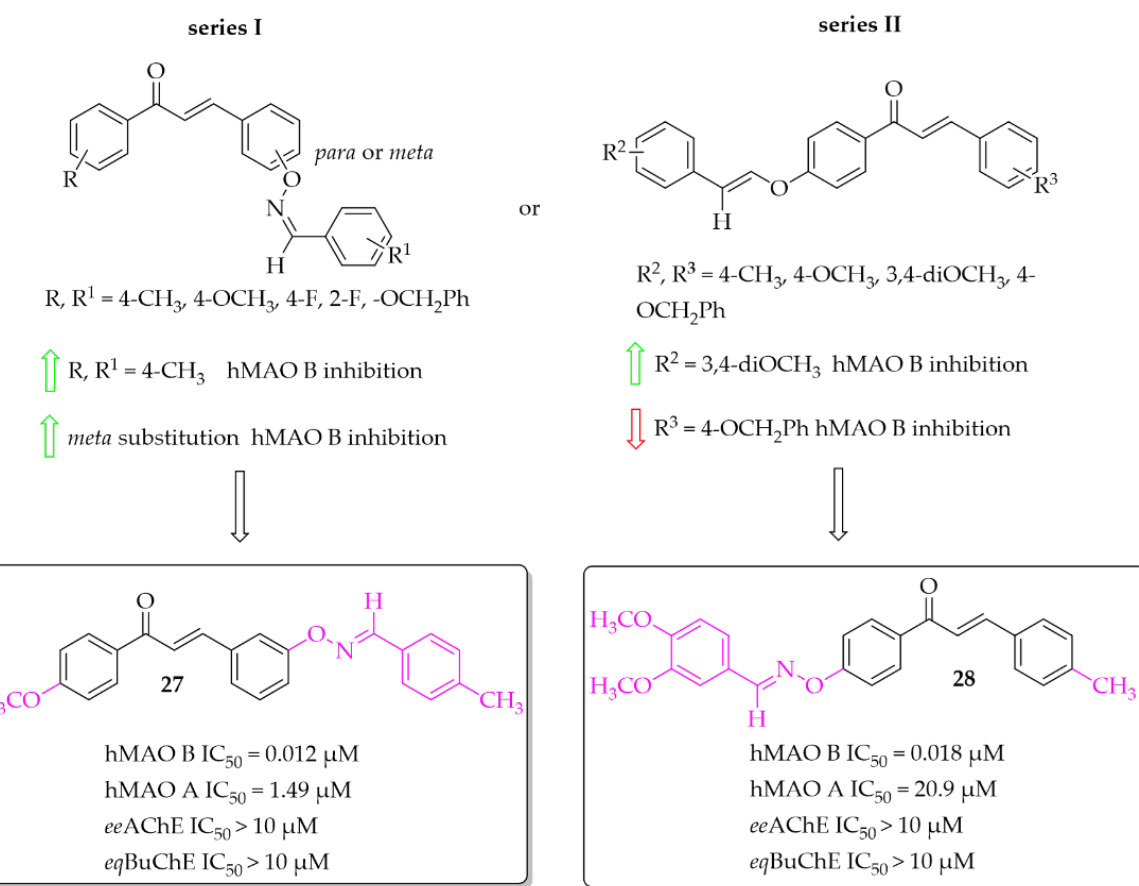
Figure 20. Aldoxime ethers and the most potent compounds in these series [46].